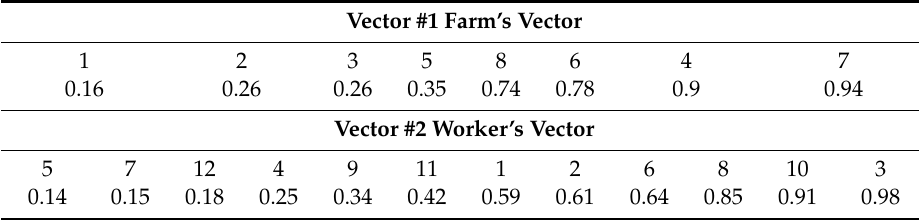
Table 3. The vectors in Table 1 after being